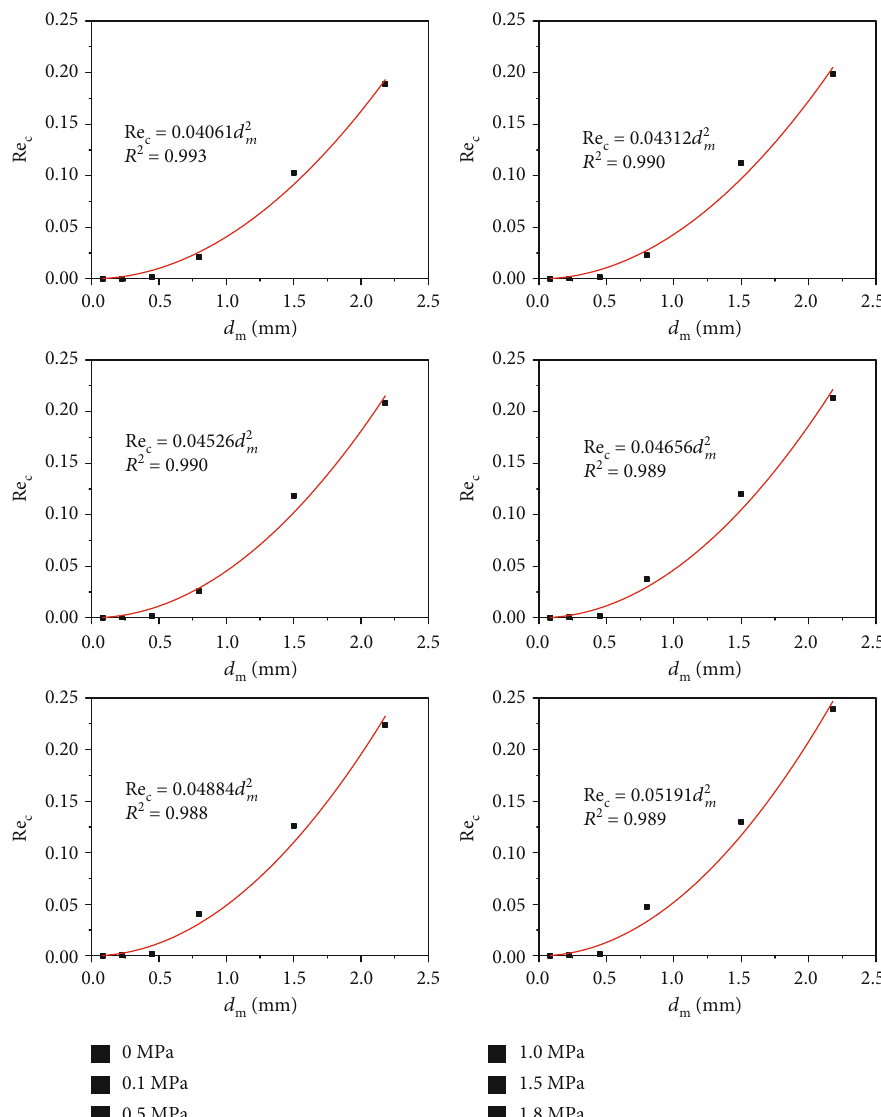
Figure 9: Relationship between the critical Reynolds number and particle size at di ff erent axial